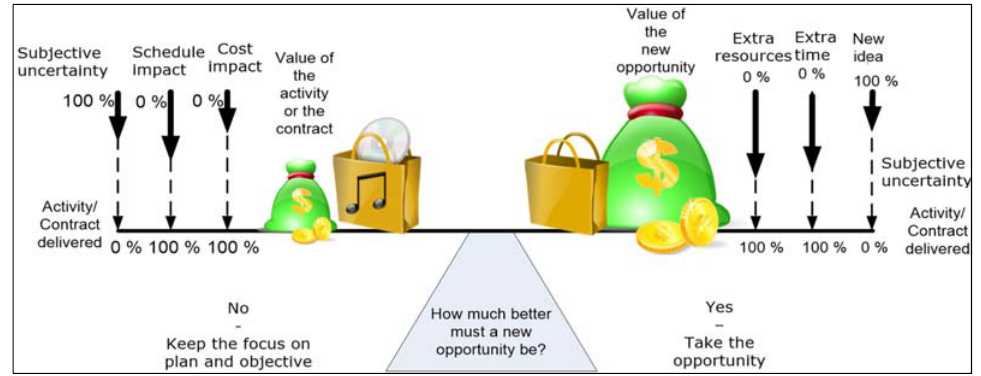
Figure 2. How much better must a new opportunity be?